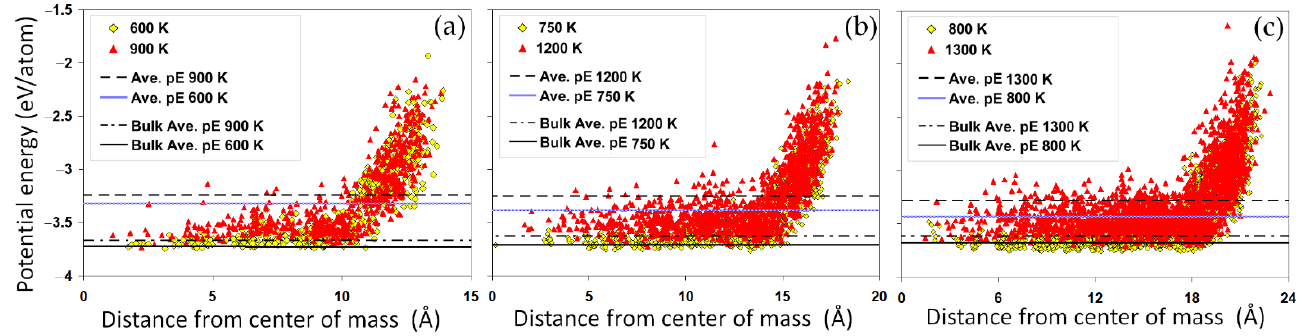
Figure 3. The radial distribution of the potential energy. The potential energy distributions for nanoparticles with ( a ) 586, ( b ) 1289 and ( c ) 2406 atoms are shown for two temperatures below and above their corresponding melting points. For comparison, the average potential energy of the nanoparticles and the bulk system are also shown (horizontal lines).